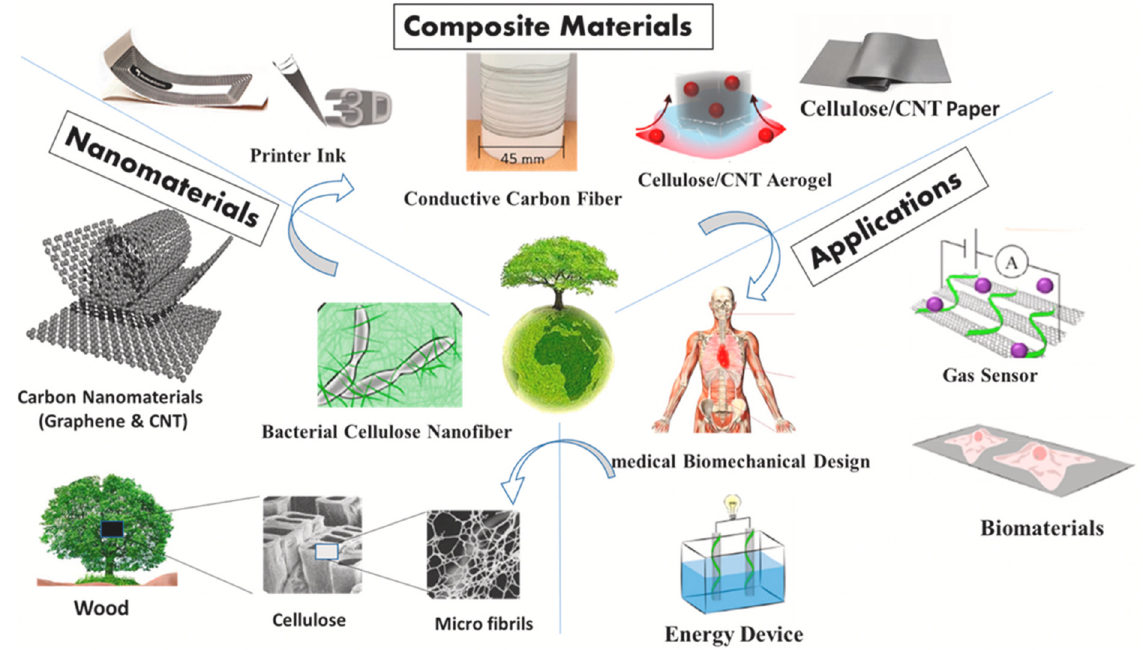
Figure 1. Polymer composite materials and its various applications. Adapted from ref. [9].